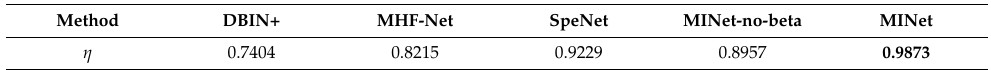
Table 5. Residual activity comparison with hyperspectral image fusion network on the HARVARD dataset. The best results are shown in